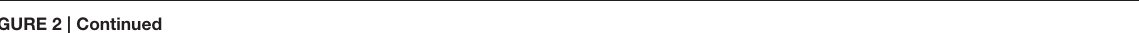
FIGURE 2 | Continued Note that the thickness of significant paths has been scaled based on the magnitude of the standardized regression coefficient and can differ between years. Panels on the right show bar plots with the sign and magnitude of standardized direct (filled bars) and indirect (striped bars) effects of each variable predicting pairwise interaction frequency. Dashed lines separate the three sets of variables representing the ecological neighborhood (on top), deterministic effects (in the middle), and neutral processes (on the